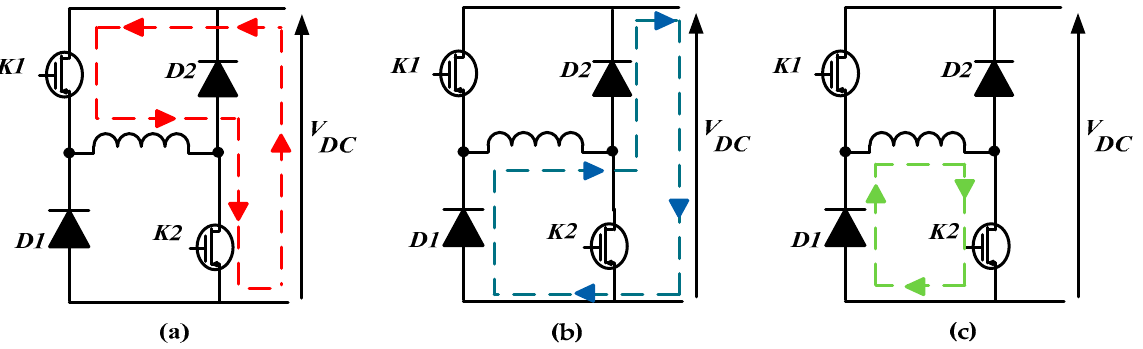
Figure 3. Operating states of switches: ( a ) excitation stage, ( b ) generation stage, and ( c ) fly-wheeling stage.